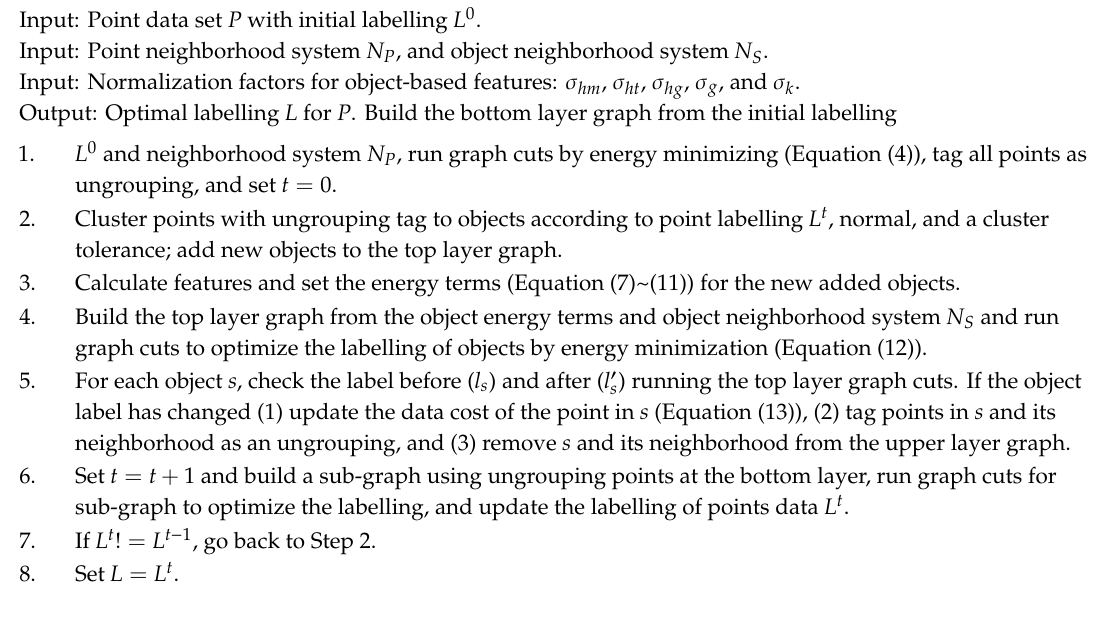
Algorithm 1. Iterative process of two-layered graph cuts